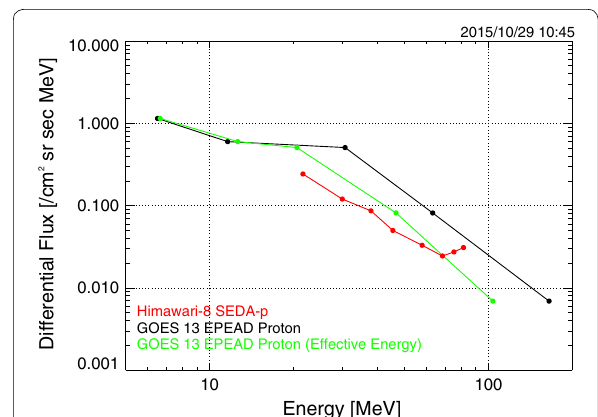
0.01 Fig. 7 Combined electron differential flux spectra from Himawari-8/ SEDA ( orange ), GOES-15/MAGED ( light blue ), and GOES-15/EPEAD ( green ) on March 9, 2015